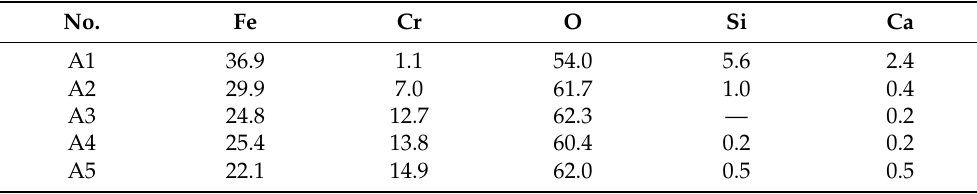
Table 4. The EDS analysis results of phase 3 in Figure 2,